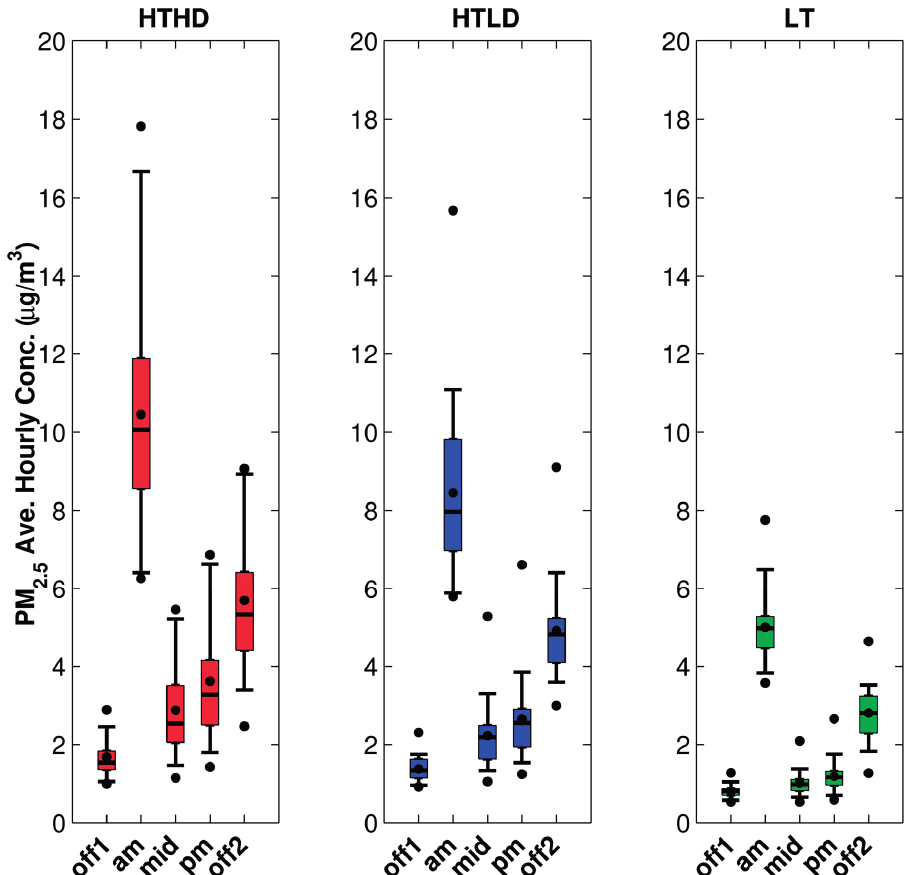
Figure 6. Temporal distributions of mobile-source component of PM the fall 2010 period, separated into high-traffic, high-diesel (HTHD), high-traffic, low-diesel (HTLD), and low-traffic (LT) participant home locations. The box represents the middle 50% of measurements, and the median is the horizontal line in the middle; the whiskers represent the 5th and 95th percentile; and the dots represent the minimum, mean, and maximum. Time periods are defined in Table